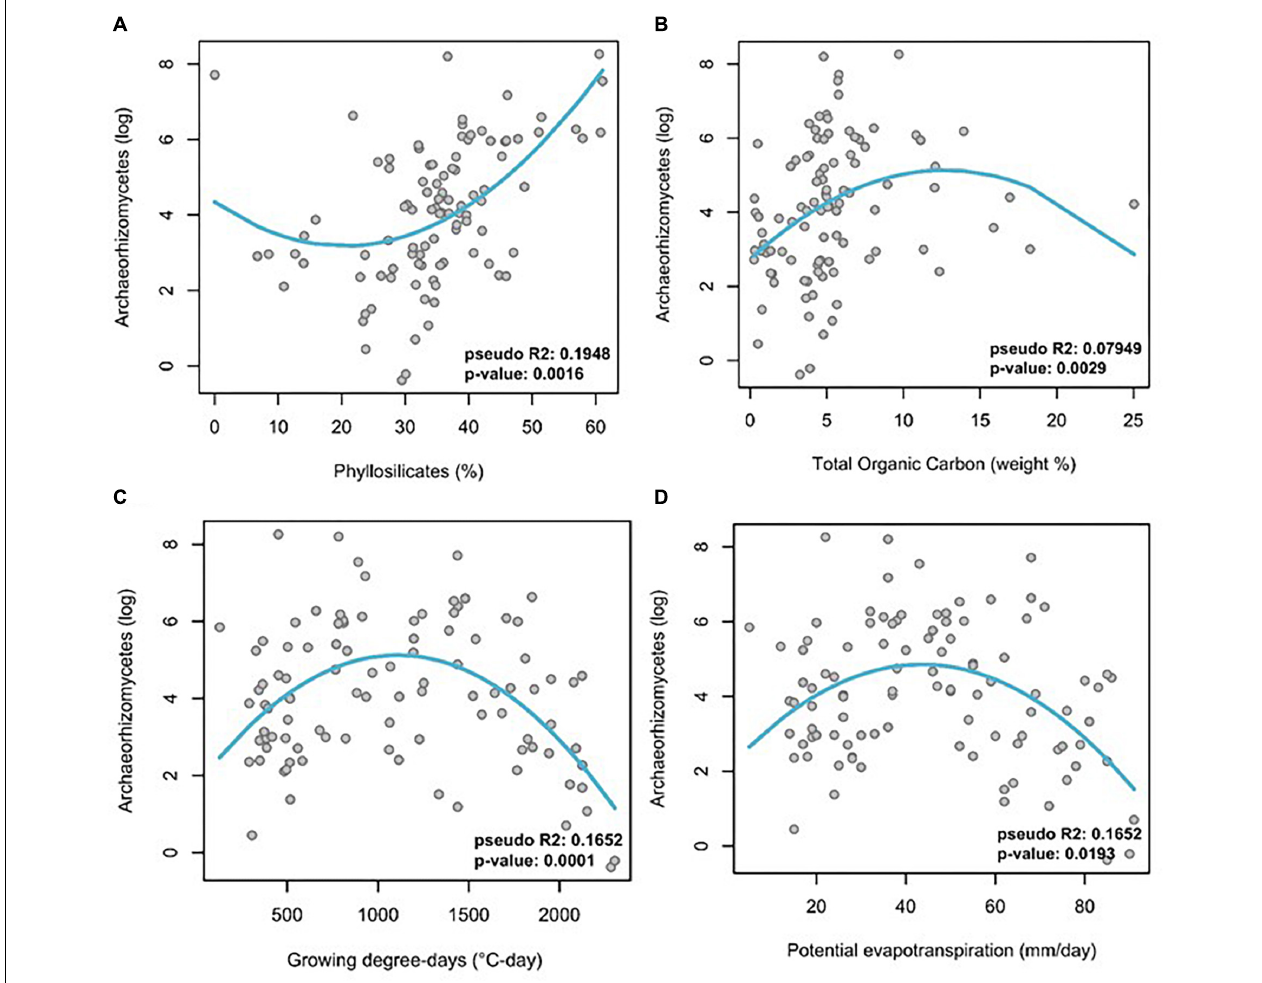
FIGURE 3 | Log-transformed relative abundance of Archaeorhizomycetes OTUs across all samples as a function of abiotic factors. (A) phyllosilicates, (B) total organic carbon, (C) growing degree-days, and (D) potential evapotranspiration. Trend curves were calculated by mean of a univariate GLM using Gaussian family and identity link function. Note the unimodal “humped-shaped” curves for three of the abiotic factors, and a reverse unimodal curve for